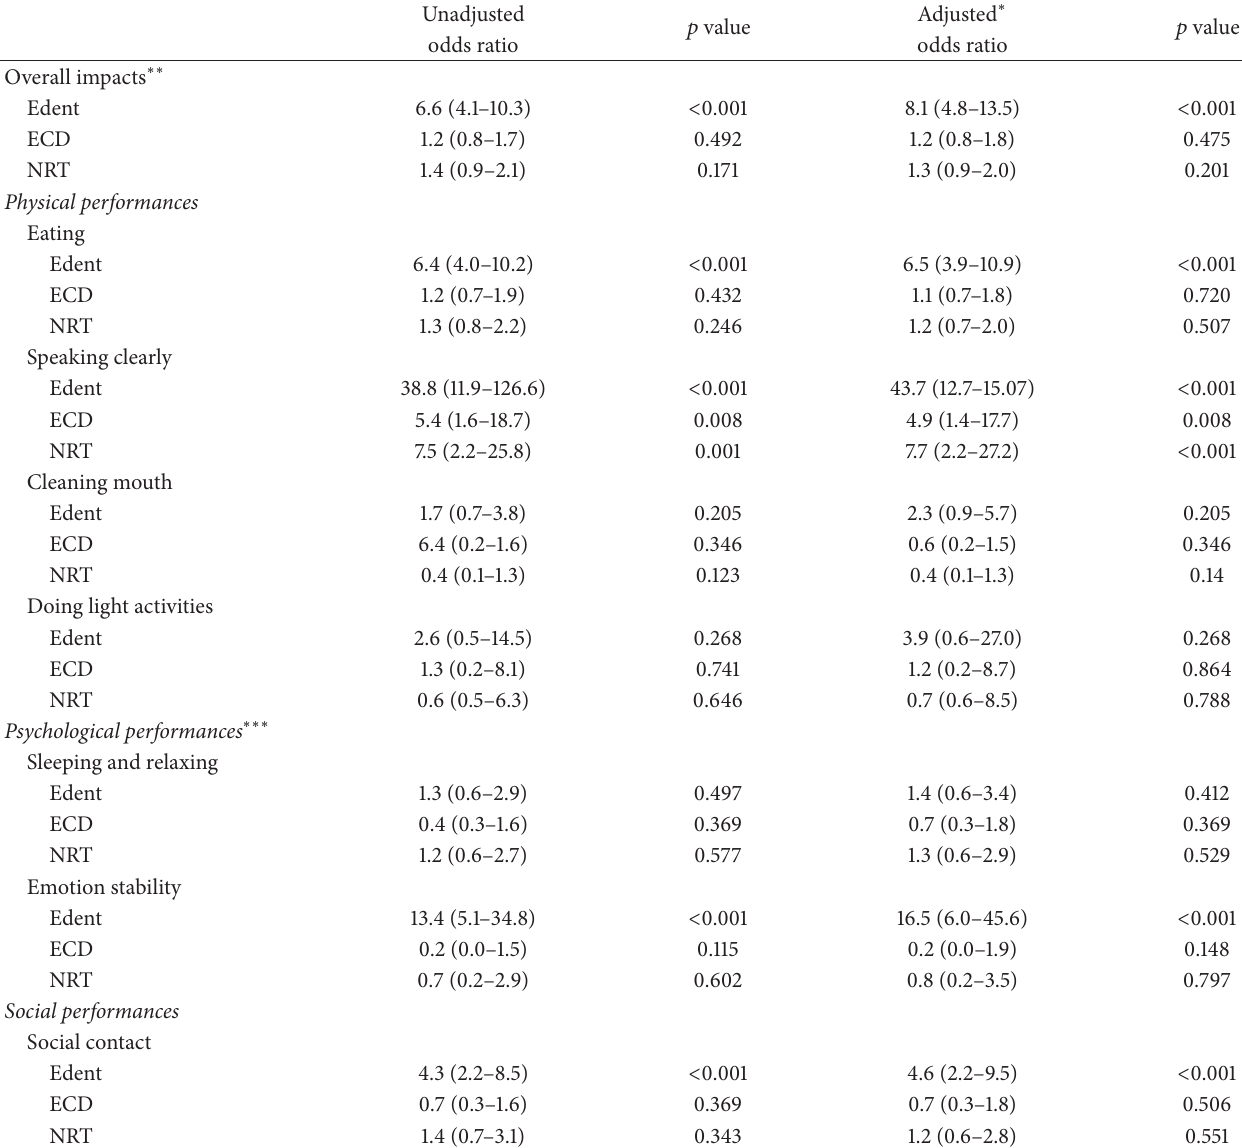
Unadjusted 𝑝 Adjusted ∗ 𝑝 value value odds ratio odds ratio